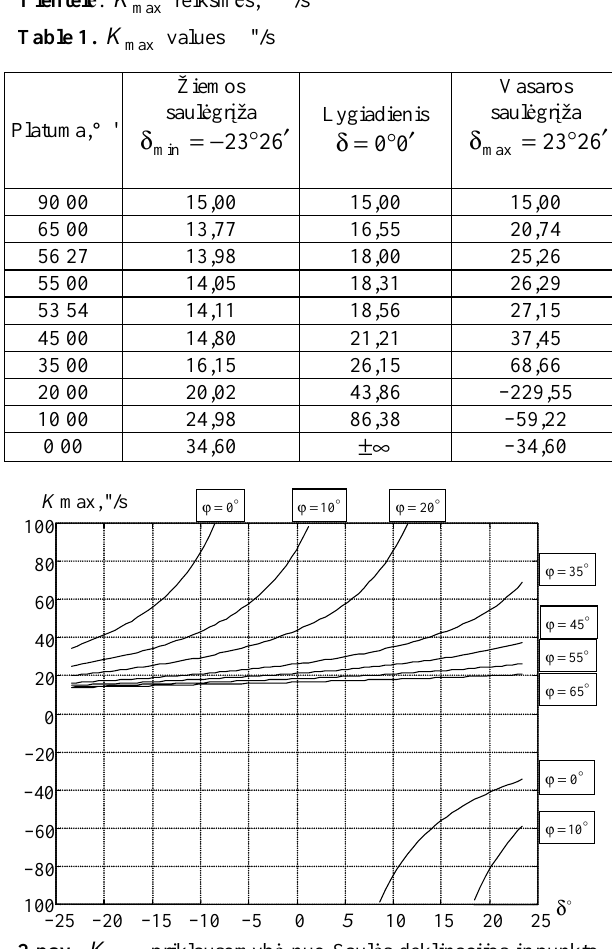
Fig 3. Coefficient K variation during the day Iš grafiko matyti, kad koeficiento K reikšmi ų kreiv ė s simetriškos tikrojo vidurdienio atžvilgiu. Tod ė